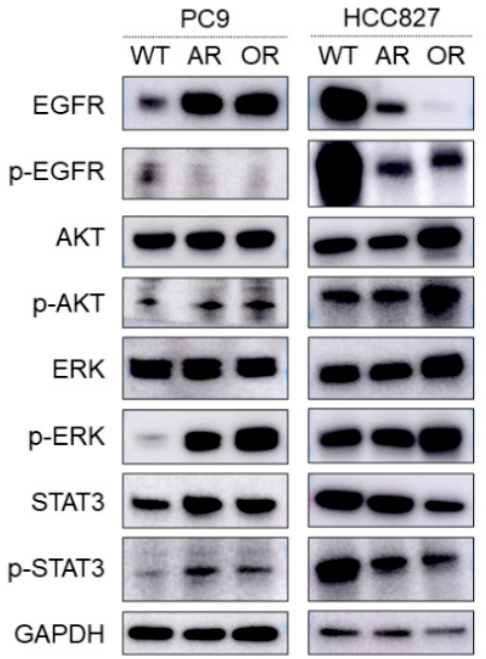
Figure 1. Protein expression levels of EGFR signaling pathway molecules, namely AKT, ERK, and STAT3 in parental cell lines and established EGFR-TKIs-resistant cell lines by Western blotting. PC-9-afatinib-resistant cell line (PC-9-AR); PC-9-osimertinib-resistant cell line (PC-9-OR); HCC827- afatinib-resistant cell line (HCC827-AR); and HCC827-osimertinib-resistant cell line (HCC827-OR).